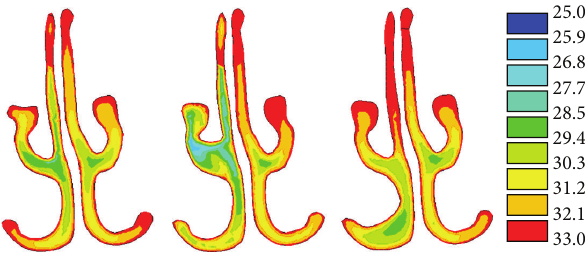
Figure 4: Airflow temperature distribution in the selected nasal model and its two